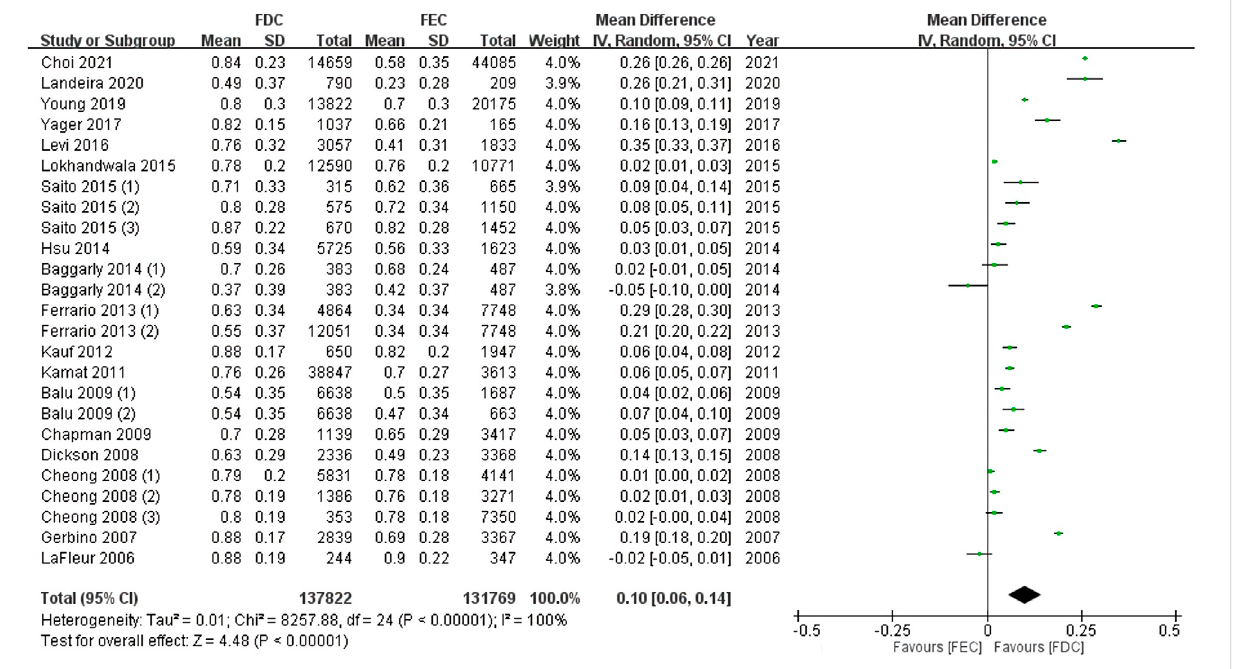
Meta-analysis of weighted mean difference in MPR or PDC in ITT population. MPR: medication possession ratio; PDC: proportion of days covered; FDC: fi xed-dose combination; FEC: free-equivalent components; ITT: Intention-to-treat